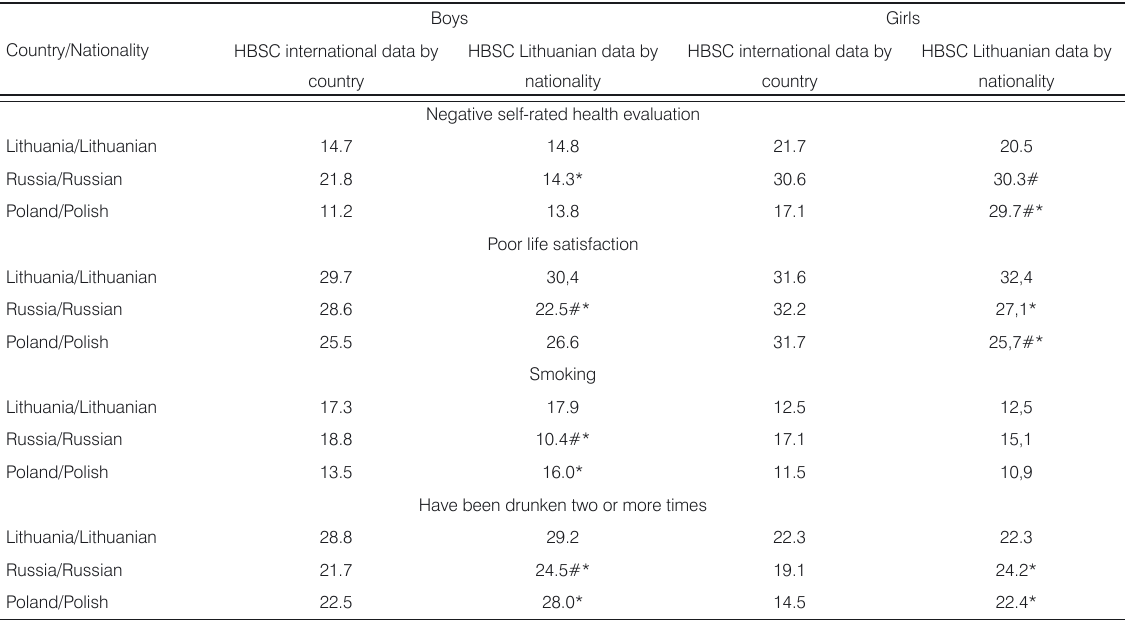
Table 6. Percentage of respondents by country and nationality, who reported negative perceived health, poor life satisfaction, smoking and episodes of drunkenness in Lithuania, Poland, Russia and among Lithuanian, Polish and Russian school-aged children in